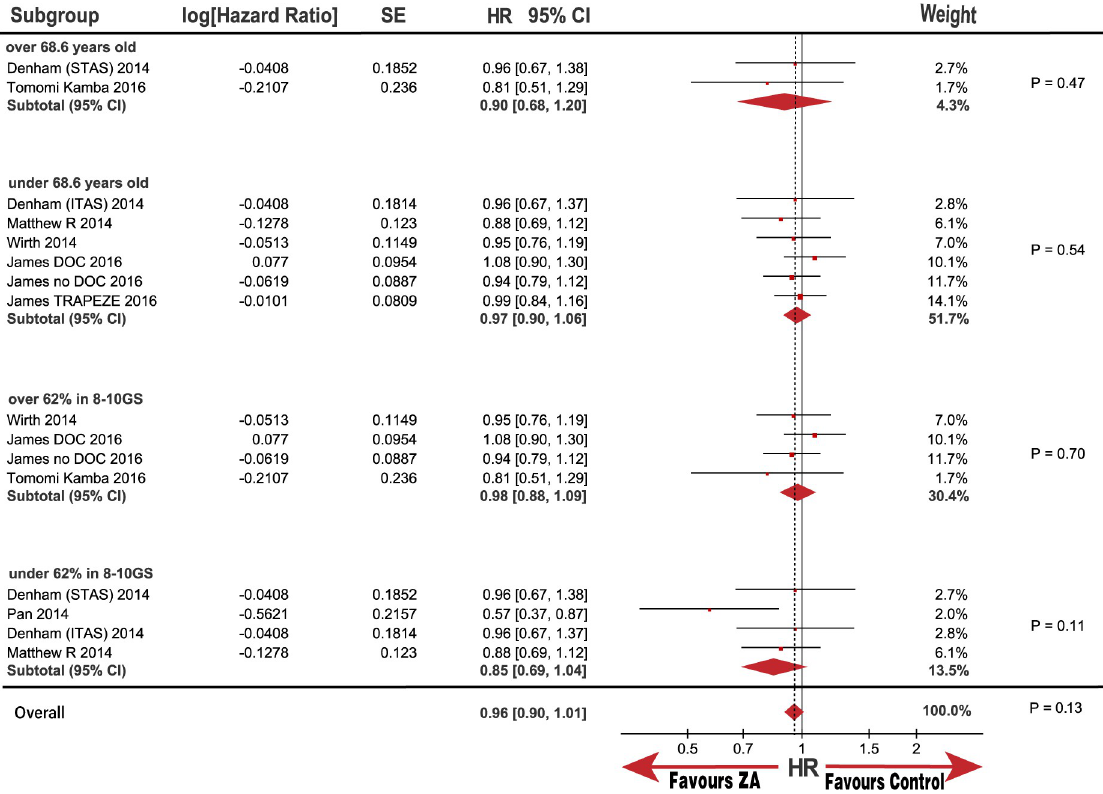
Fig 6. Forest plot with hazard ratio (HR) of OS in subgroup of age and